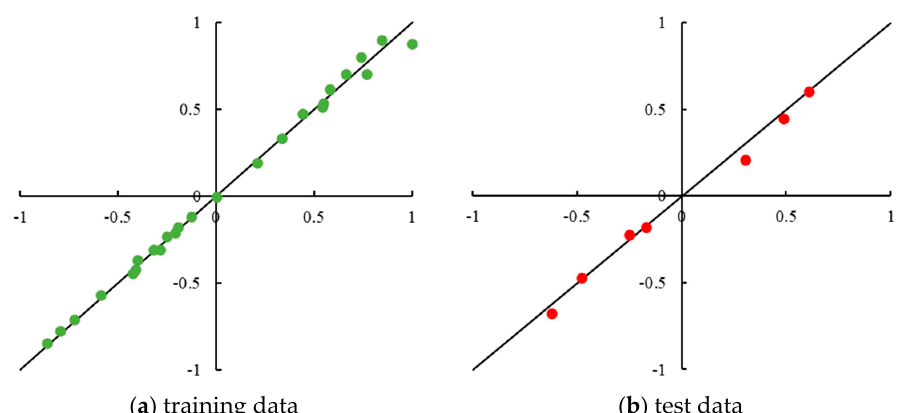
Figure 9. Comparison of experimental data and predicted data for BPNN.